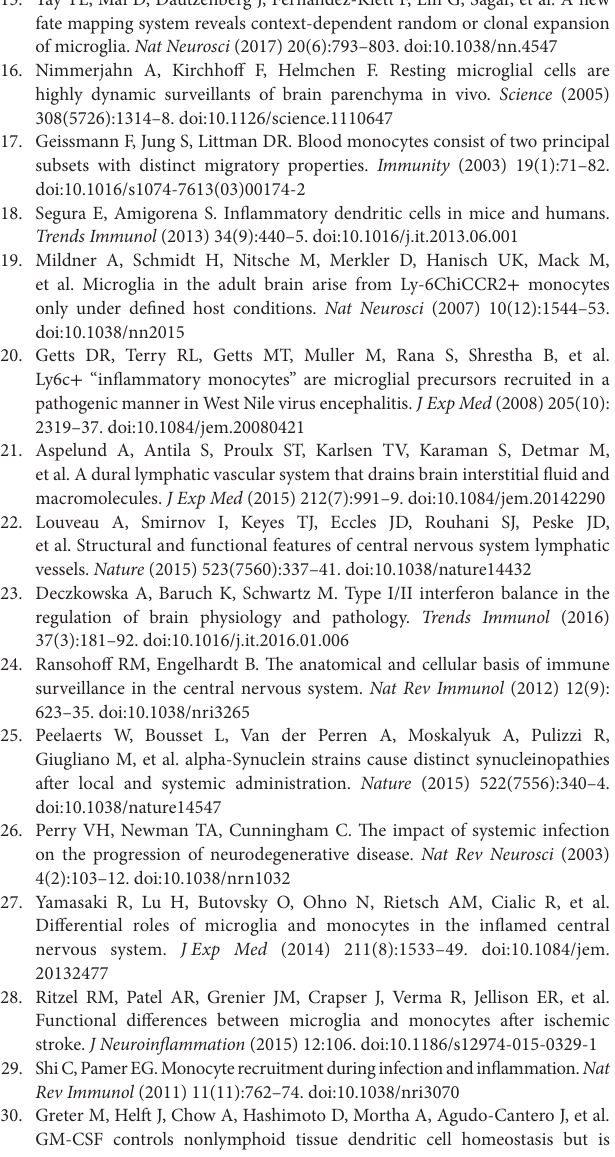
FigUre s2 | Two-step intracellular staining Ctrl. Mice were treated i.p. with 40 µg of lipopolysaccharide (LPS) (1,6 mg/kg) for four consecutive days to induce neuroinflammation. Twelve hours post the last injection, mice were euthanized and immune cells isolated and labeled for subsequent flow cytometric analysis. CD11b/Ly6C vs Alexa Fluor 488 flow cytometry density- plots illustrating the secondary antibody control from the intracellular labeling of CCR2 and CX 3 CR1. Representative rectangle gates were used in all cases for statistical purpose rather than for selection of a cell population. FigUre s3 | Weight loss comparison between wild-type (WT), IFN-g − / − , and IFNAR − / − mice strains following LPS stimulation. Weight loss was assessed in WT, IFN-g − / − , and IFNAR − / − mice following the i.p. administration scheme with vehicle or 40 µg of lipopolysaccharide (LPS) (1,6 mg/kg) for four consecutive days to induce neuroinflammation. Results are an average of three independent experiments ( n = 3–4 animals per group) for each knockout mice strain. Data are expressed as mean ± SEM. Statistical significance levels were set as follows: ### if p < 0.001 (WT-Veh, IFN-g − / − Veh, and IFNAR − / − Veh vs WT-LPS, IFN-g − / − LPS,